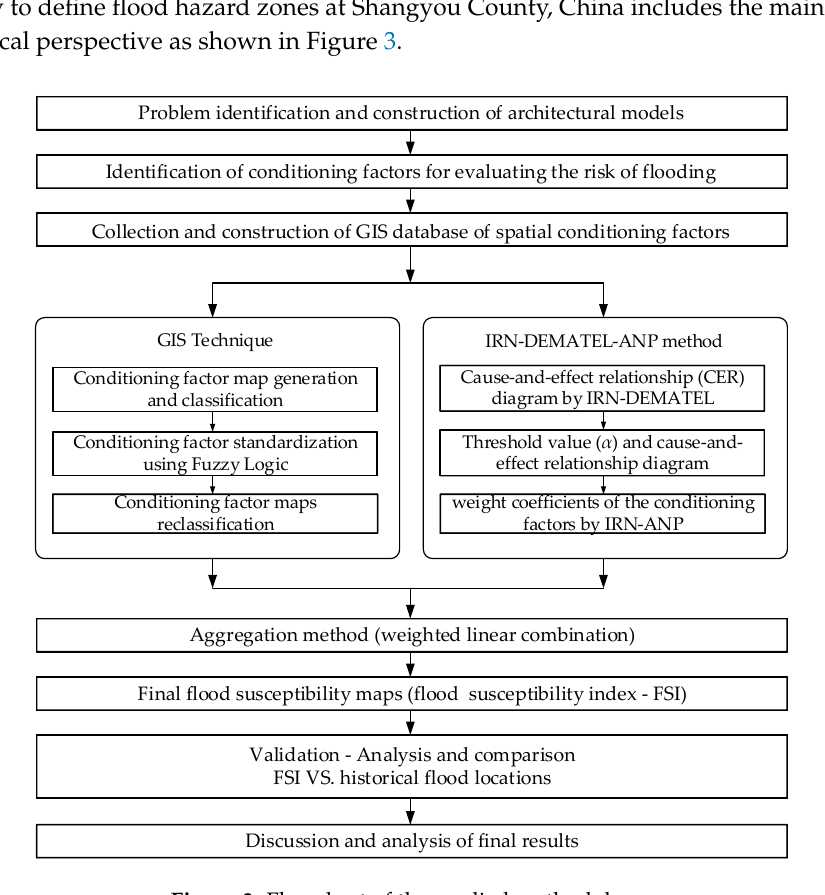
Figure 3. Flowchart of the applied methodology.